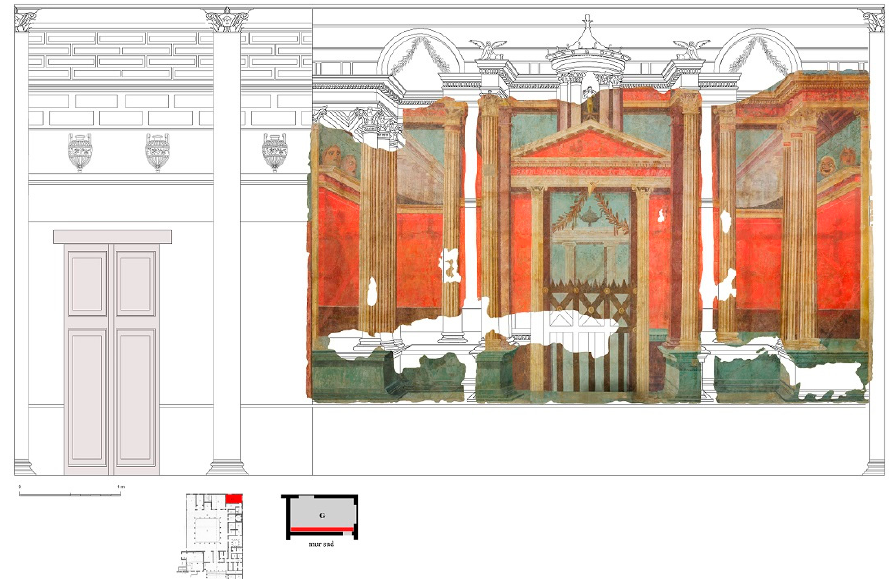
Figure 5. Southern wall of Room G from the Villa of Boscoreale, restitution drawing of the wall’s overall design (by F. Ory; frescoes on display in Mariemont, Musée royal B 96); © F. Ory (with kind permission).